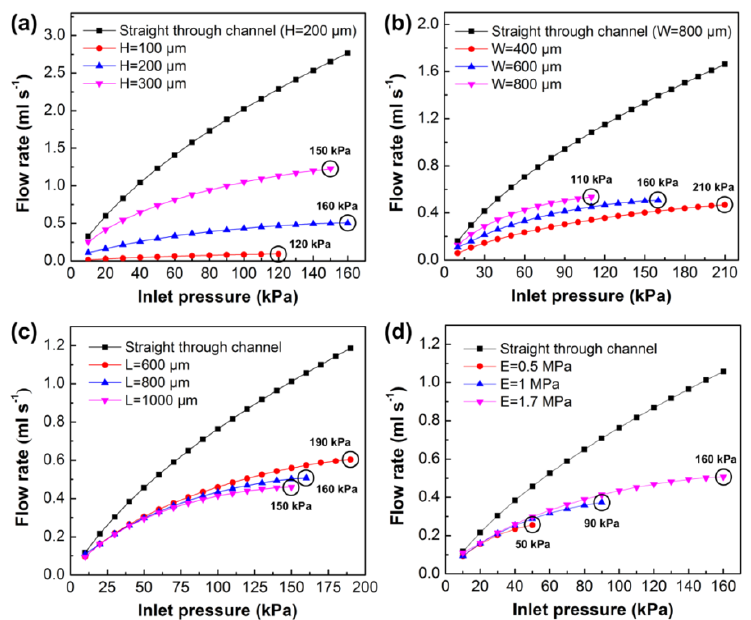
Figure 6. Simulation of the flow rate curve for various parameters of ( a ) fluidic channel height (H), ( b ) fluidic channel width (W), ( c ) control channel length (L), and ( d ) Young’s modulus (E). The circle in the figure indicates the saturation pressure of the model in the simulation process. The saturation pressure represents the maximum pressure of the model before simulation fails.